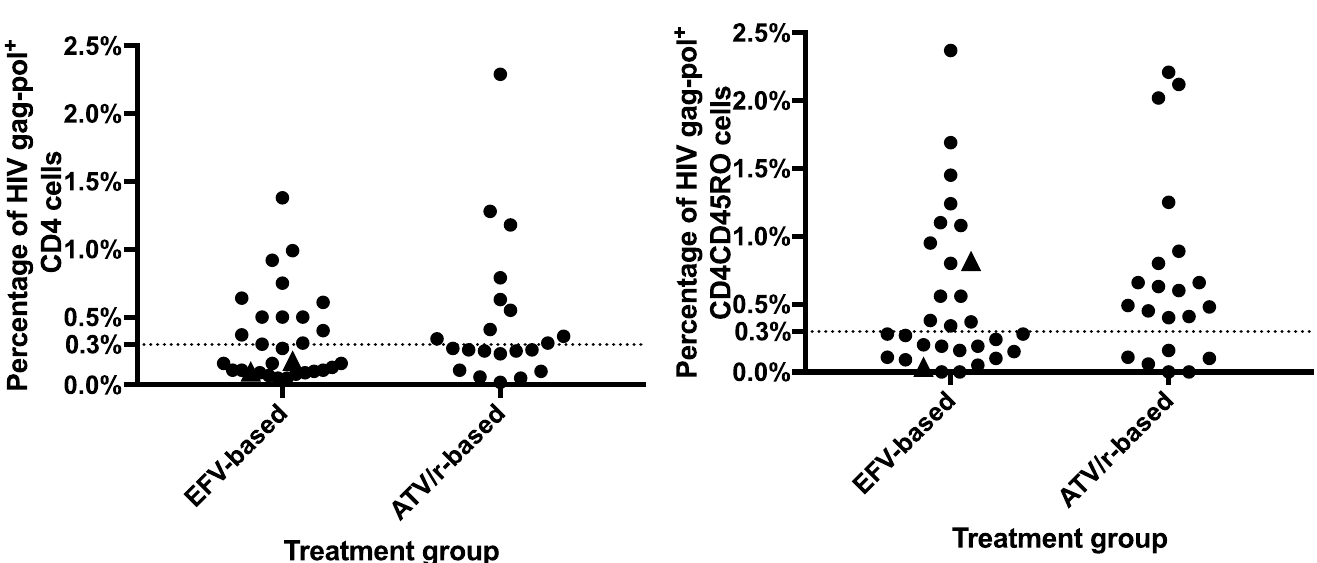
Fig 1. Simultaneous ultrasensitive subpopulation staining/hybridization in situ (SUSHI) patient results by antiretroviral regimen in CD4 + and CD4 + CD45RO + T-cells. Two patients experienced a transient increase of their viral load in the follow-up period (black triangles). EFV: efavirenz, ATV/r: atazanavir/ritonavir.